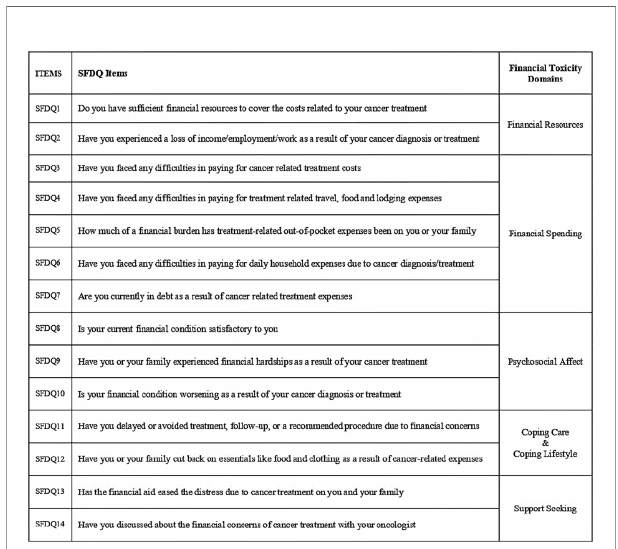
FIGURE 4 | Final 14-item Subjective Financial Distress Questionnaire